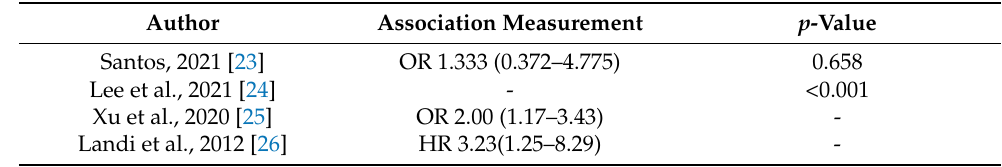
Table 3. Association measurements used and analyzed in the studies included in the systematic review, São Paulo, SP, Brazil, 2022.